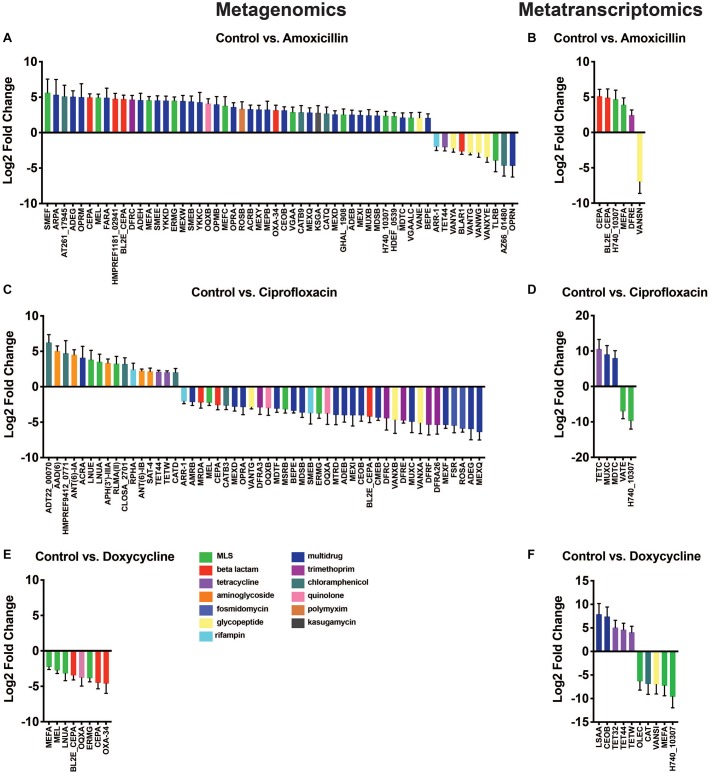
Differential abundance of antibiotic resistance genes. Changes in ARG abundances after antibiotic treatment observed in metagenomic (A,C,E) and metatranscriptomic data (B,D,F). Bars represent change in gene/transcript abundance after exposure to antibiotics displayed as log2 fold change ± standard error (log2FC ≥ 1.5/ ≤ –1.5 and padj < 0.05) (Full ARG class counts available in Supplementary Table S3).